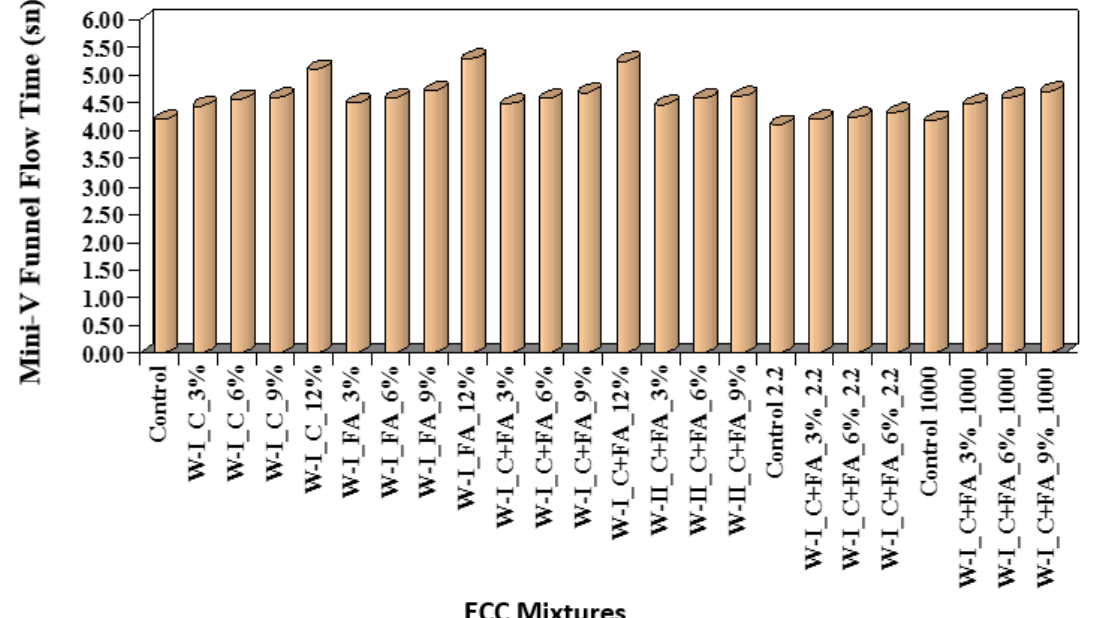
Figure 9. Mini-v-funnel flow time values of ECCs based on Ref. [33].